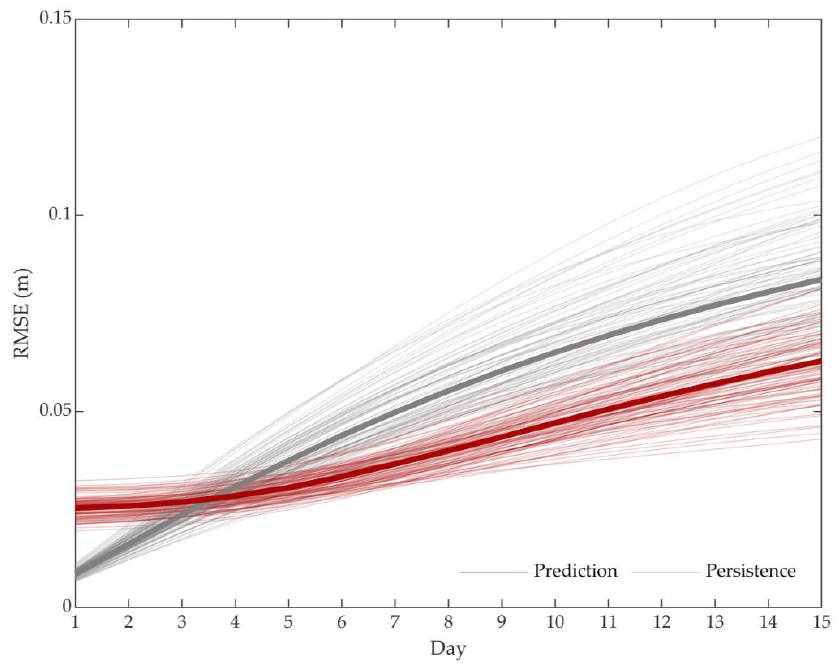
Figure 8. Averaged RMSE of SLA between prediction (red) and persistence (gray) from 18 April 2014 to 31 December 2017. The thin line is the 15-day average, and the thick line is the three-year average.